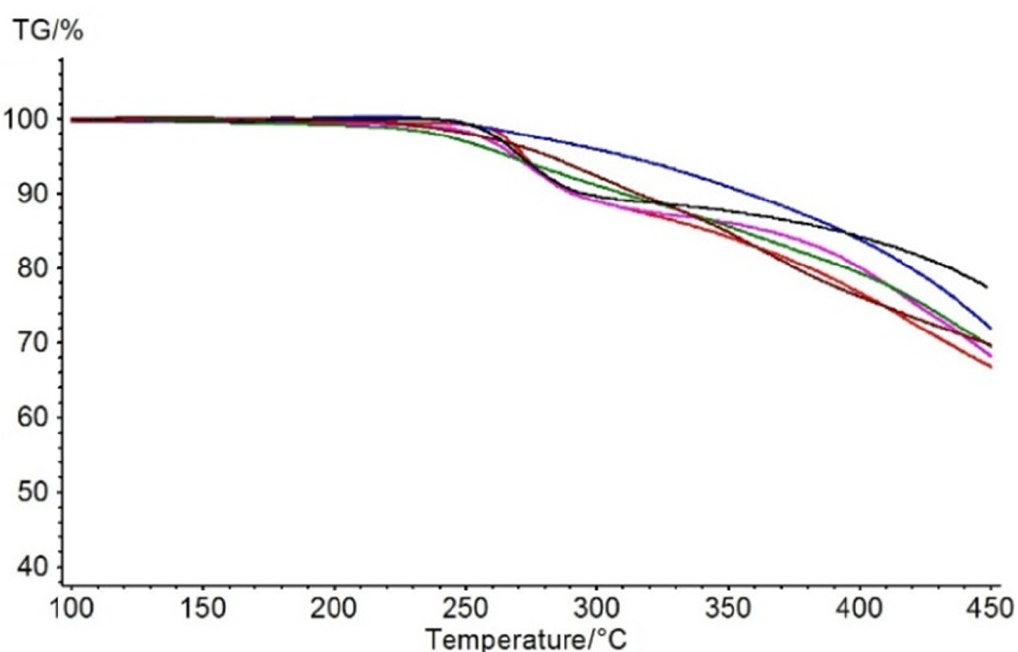
Figure 3. TGA curves of Chr-An1 (green), Chr-An2 (red), Chr-An3 (blue), Chr-Car (black), Chr-PT (magenta) and Chr-TQ (brown). Table 2. Thermal properties of the studied